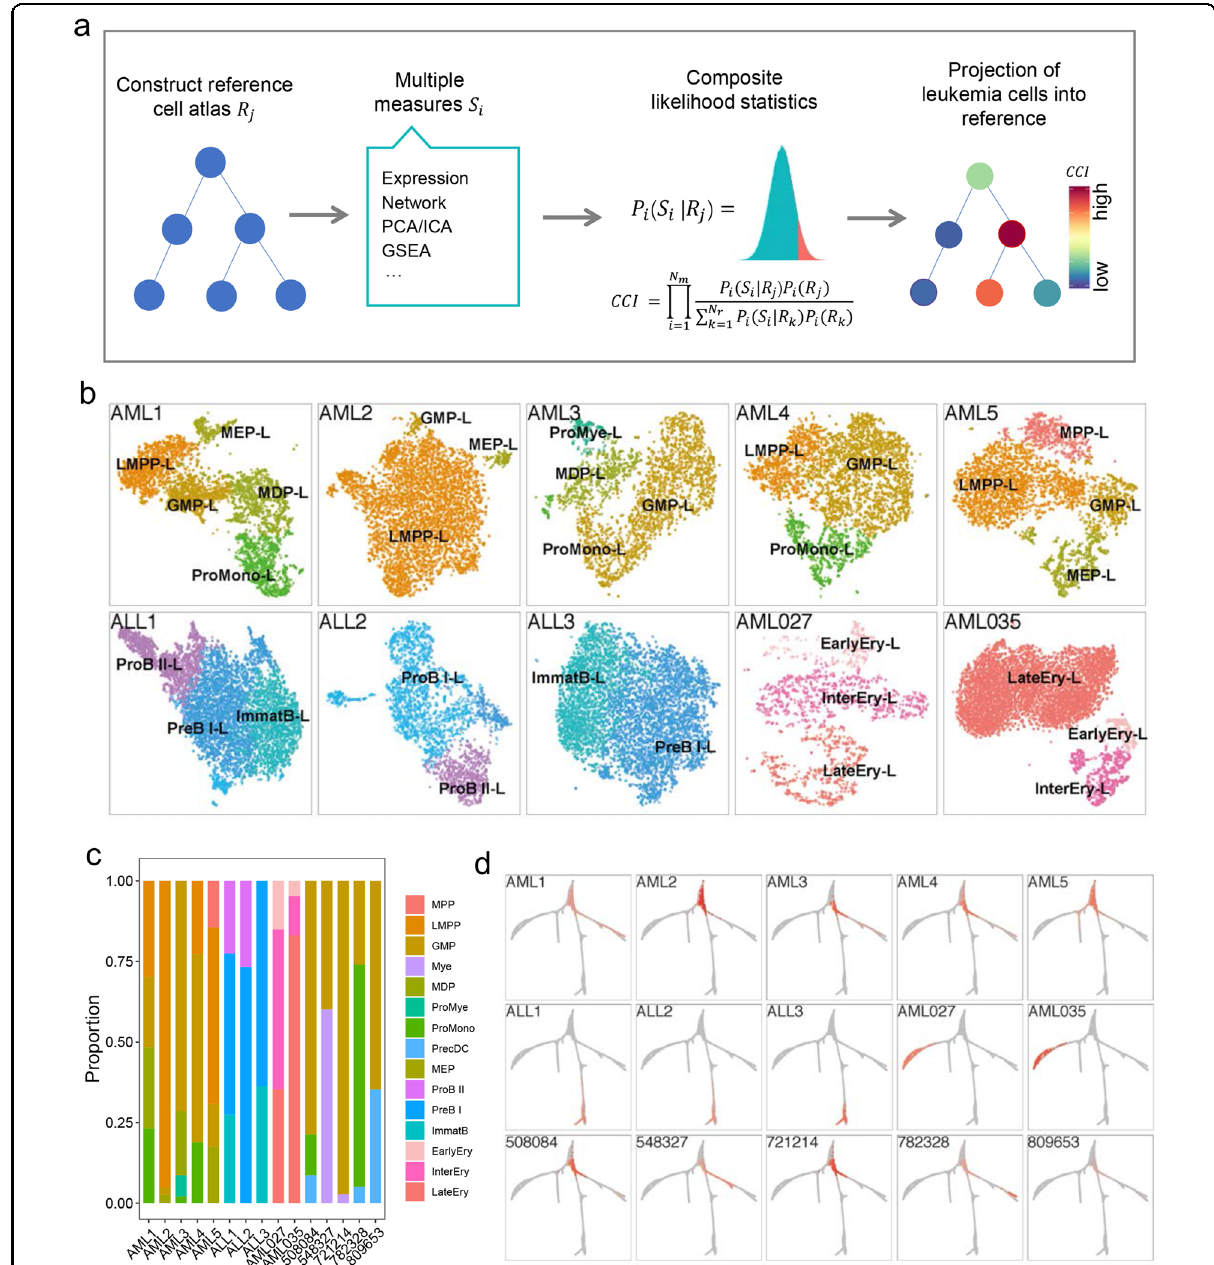
Fig. 4 Searching the healthy counterparts of leukemia cells for comprehensive understanding of leukemogenesis. a Schematic of CCI for searching healthy counterparts of leukemia cells. b The healthy counterpart of each leukemia cell subpopulation in the ten leukemia patients, in which the healthy counterparts of leukemia cells from the sample patient are different. Each leukemia cell subpopulation was named after its counterpart by superscript “ -L ” . c Bar plot of leukemia cell subpopulations and their abundance. d Mapping of leukemia cells onto hematopoietic lineages. Gray indicates reference hematopoietic tree while red indicates leukemia cells. The leukemia cells from ALLs were projected into lymphoid lineage, while leukemia cells from AMLs were projected into different non-lymphoid lineages according to their